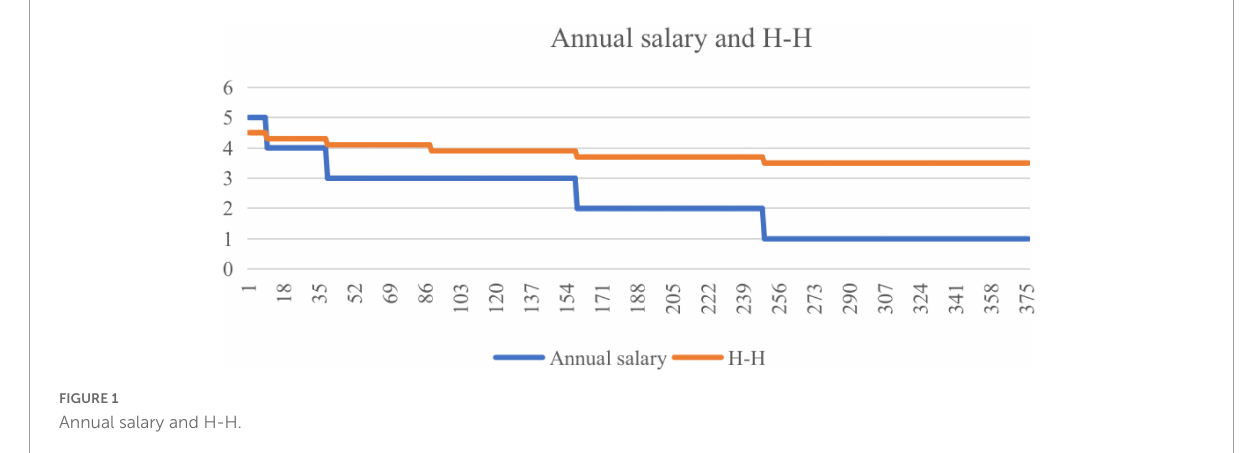
FIGURE1 Annual salary and H-H.